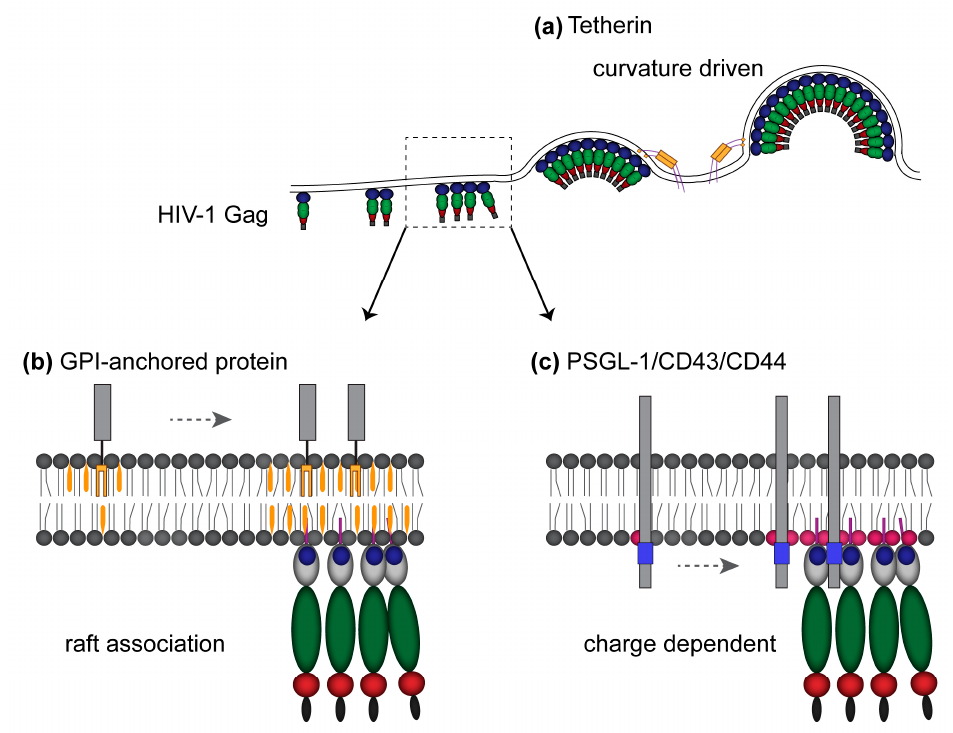
Figure 3. Mechanisms of host protein enrichment to HIV-1 assembly sites. ( a ) Membrane curvature promotes the incorporation of tetherin into nascent virions. ( b ) Preference of cellular proteins for raft-like domains promotes their enrichment at virus assembly sites. A GPI-anchored protein is shown as an example. ( c ) PSGL-1, CD43, and CD44, which contain a polybasic region in their cytoplasmic tails, cocluster with Gag in an HBR-dependent manner, potentially mediated by a polyacidic entity such as clusters of acidic lipids including PI(4,5)P2.